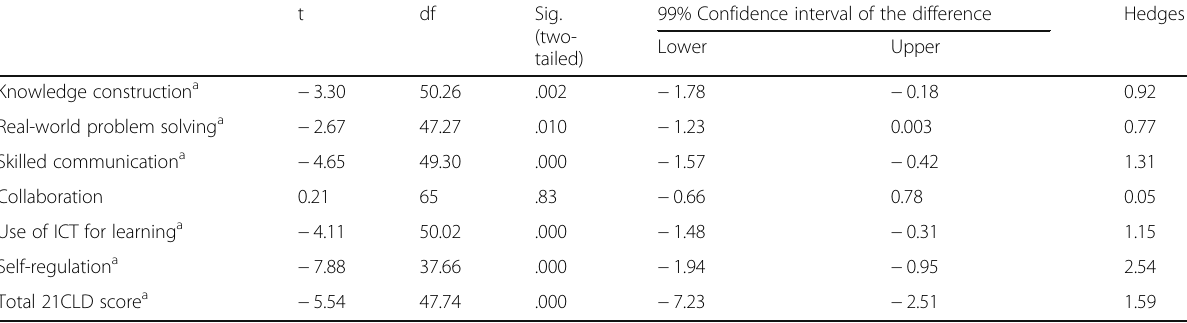
Table 7 Independent samples test comparing short-term to long-term lesson plans